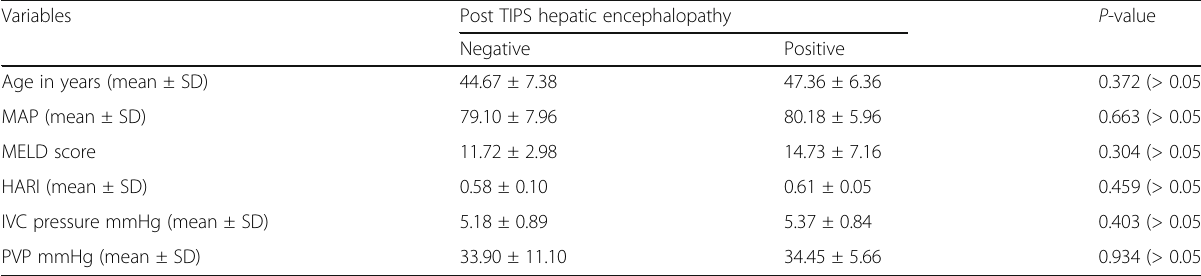
Table 6 Comparison of the studied variables in relation to post-TIPS incidence of hepatic encephalopathy